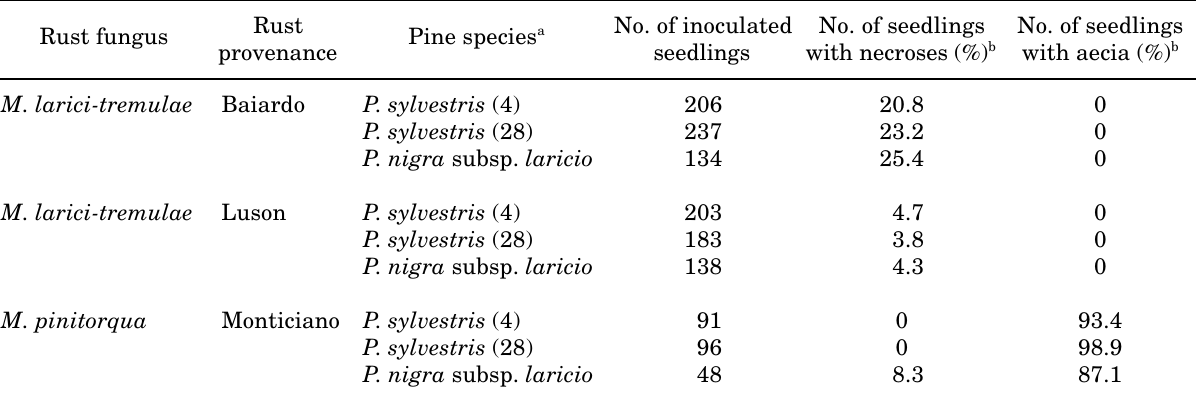
Table 2. Cortical necroses and aecia on shoots of Pinus sylvestris and P. nigra subsp. laricio seedlings inoculated with Melampsora larici-tremulae from Baiardo, M. larici-tremulae from Luson and M. pinitorqua from Monticiano. No. of inoculated No. of seedlings No. of seedlings Rust Rust fungus Pine species a provenance seedlings with necroses (%) b with aecia (%) b